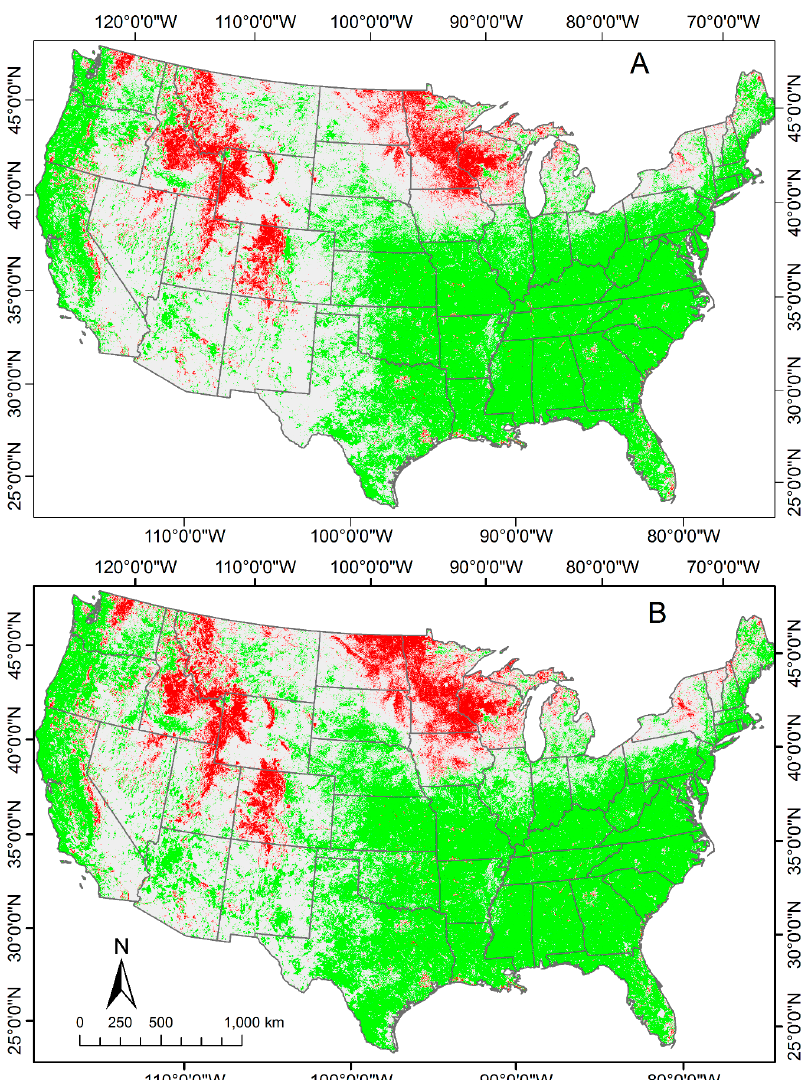
Figure 1. Pixels (1 km × 1 km) with significant temporal trend for the monthly NDVI from 1989 through 2013 in contiguous 48 U.S. states, determined by: ( A ) significant changes in greenness (univariate autoregression; Equation (1)); and ( B ) multivariate autoregression (Equation (4)). Sample size is 300 for each pixel. Green indicates significant ( p < 0.05) increase in greenness (i.e., NDVI); red indicates significant decrease in greenness.